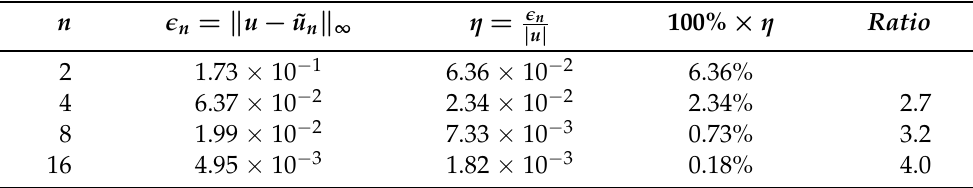
Table 5. IE (48), λ A = 2. QM: Trapezoidal rule and Taylor series.